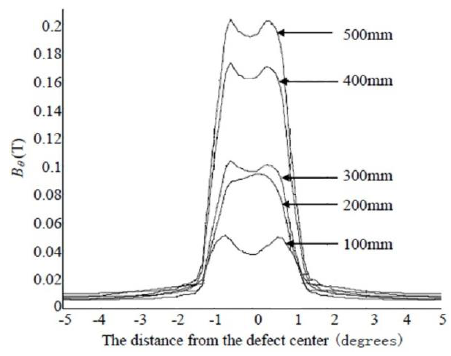
Figure 8. Radial MFL signals with different length.